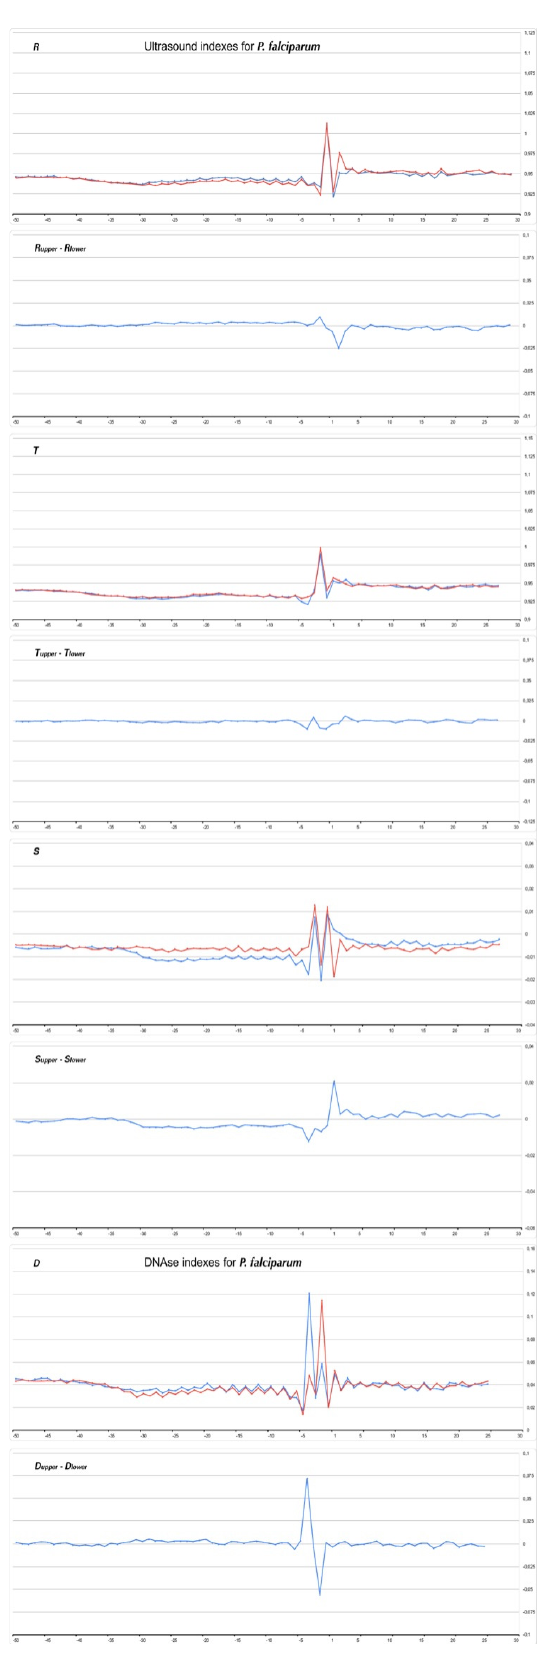
Figure 11. Profiles of ultrasonic cleavage indexes and DNase I cleavage indexes for P. falciparum core